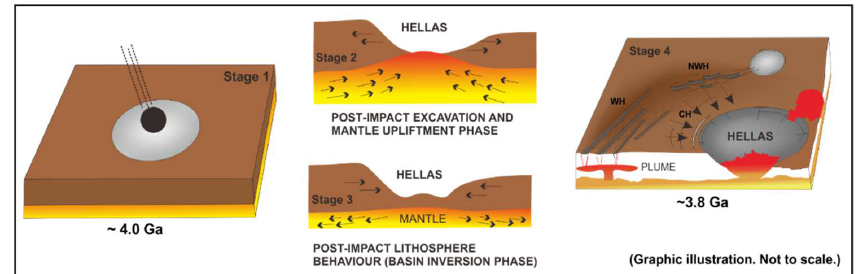
Figure 8. A schematic model explaining the development of the extensional structures. Stage 1. A giant impact (~4.0 Ga) excavates the upper crust and penetrates up to the upper mantle. Stage 2 . Impact-induced frictional heat raises temperatures of the mantle, creating a density deficit relative to the ambient, and it induces a visco-elastic flow, and MASCON develops. Stage 3 . Due to conductive cooling and viscoelastic evolution, gravitational collapse happens. The collapse drags the upper lithosphere towards the interior of the basin. Consequently, fractures open in the surrounding basin to accommodate the vacant space. Stage 4 . A mantle plume originates around ~3.8 Ga and initiates rifting.